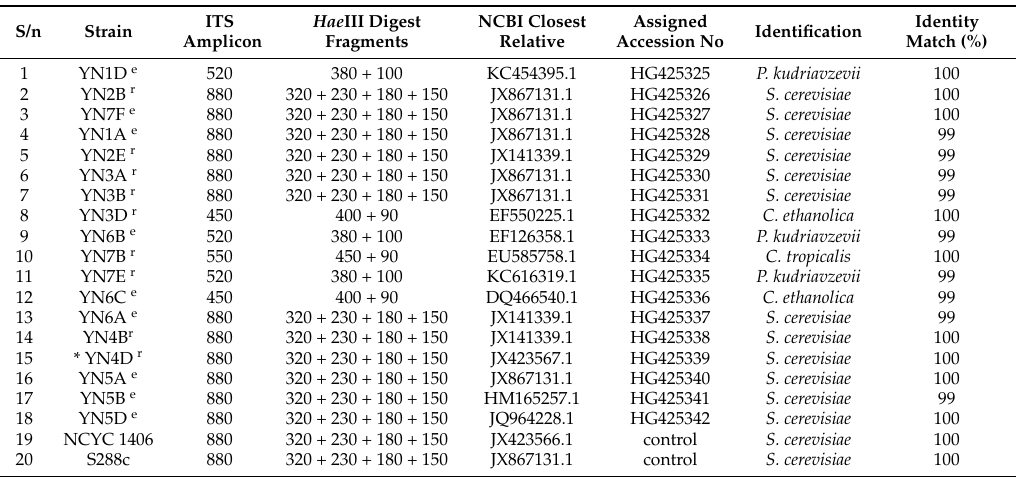
Table 1. Identification of yeasts strains from palm wine sourced from two different palm tree species.